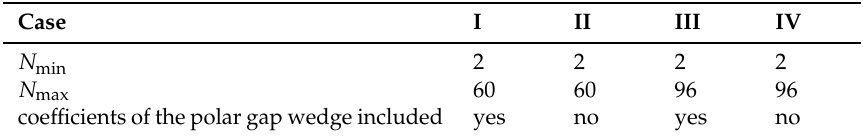
Table 1. SH coefficient combinations defining the cases that are used to compute ice mass trends for the Greenland catchment areas based on SH gravity field models. N min and N max denote the minimum and maximum SH degrees of the coefficients included.